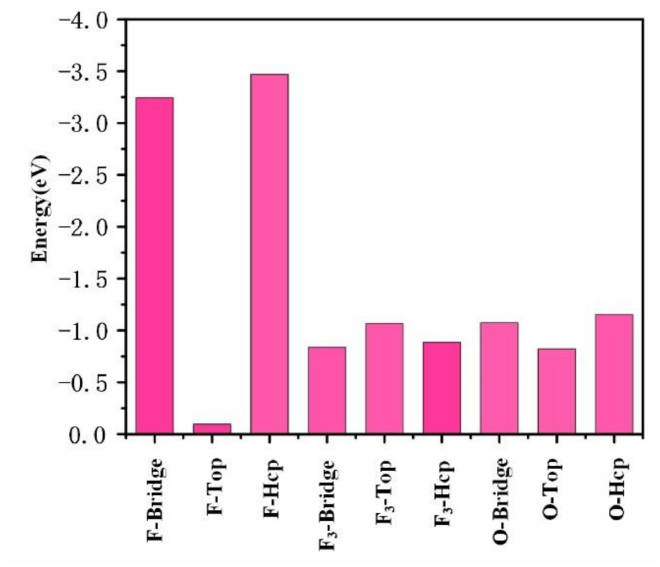
Figure 9. Total energy change before and after simulation